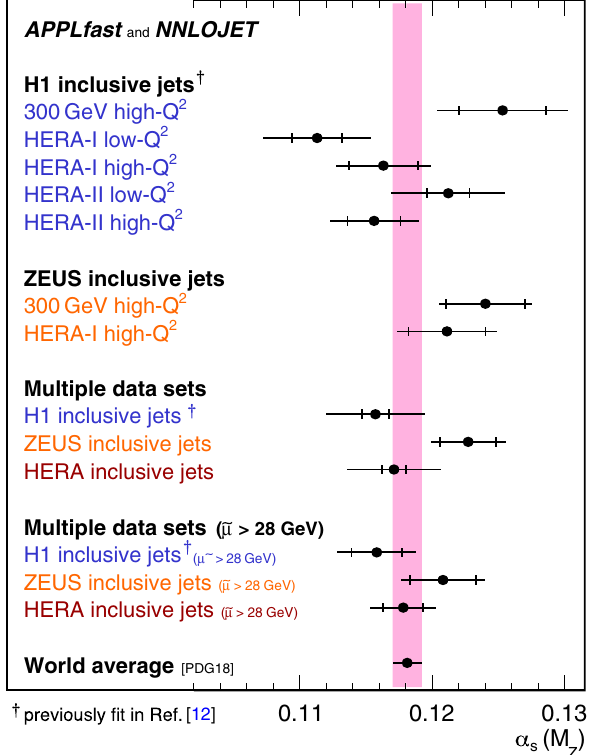
Fig. 5 Summary of α s ( M Z ) values in comparison with the world aver- age value. The inner error bars indicate experimental uncertainties, and the full errors the total uncertainty, comprised of the experimental and theoretical uncertainties. The lower set of values represent fits to data restricted to ˜ μ > 28 GeV